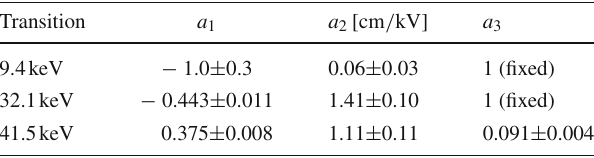
Fig. 16 Light and charge yields of the 83m Kr transitions as function of applied electric field E , measured using the HeXe setup (circles). The data points from Manalaysay et al. [27] (crosses) and Baudis et al. [31] (squares) are also shown. The dotted lines show a fit with the modified Thomas-Imel box model given in Eq. 1 (data points are provided online [32]) Table 1 Best fit values for the field dependent light and charge yield variation for 83m Kr (shown in Fig. 16) explained by the modified Thomas–Imel box model shown in Eq. 1. Only statistical uncertain- ties are